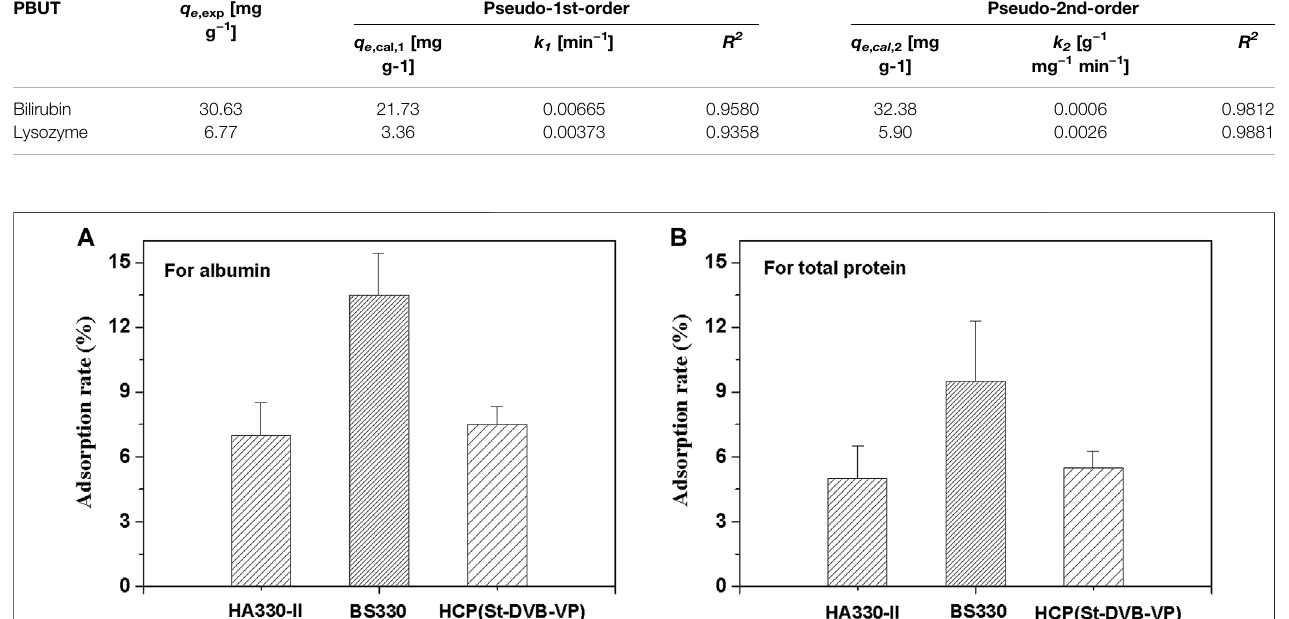
FIGURE9| Calculatedadsorptionratesofthe (A) albumin and (B) totalprotein fromhumanplasmaonvarious adsorbents.Allvaluesareexpressedasthemean ± SD of three independent measurements.